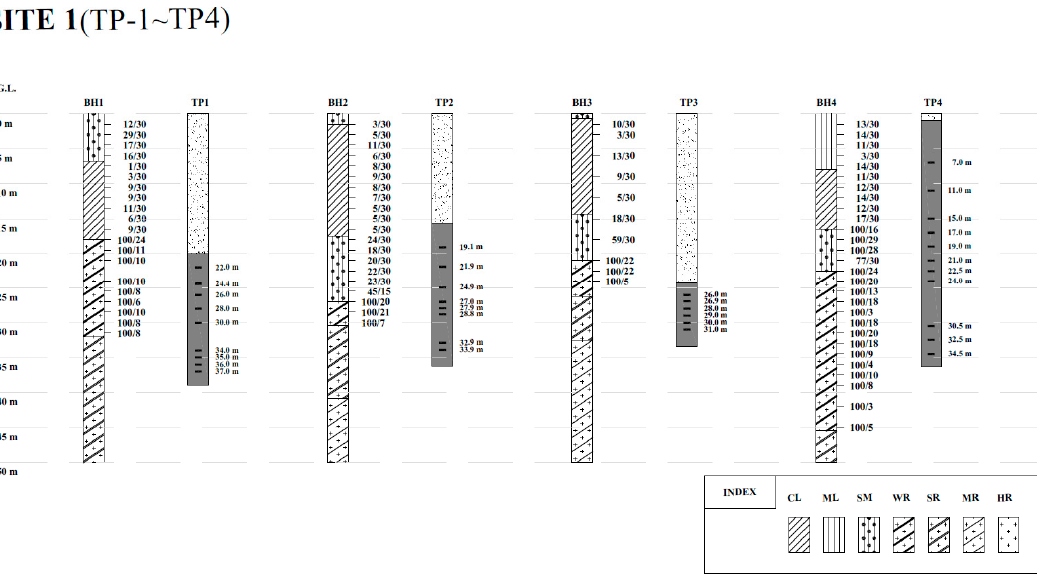
Figure 1. Site investigation results (Site 1).